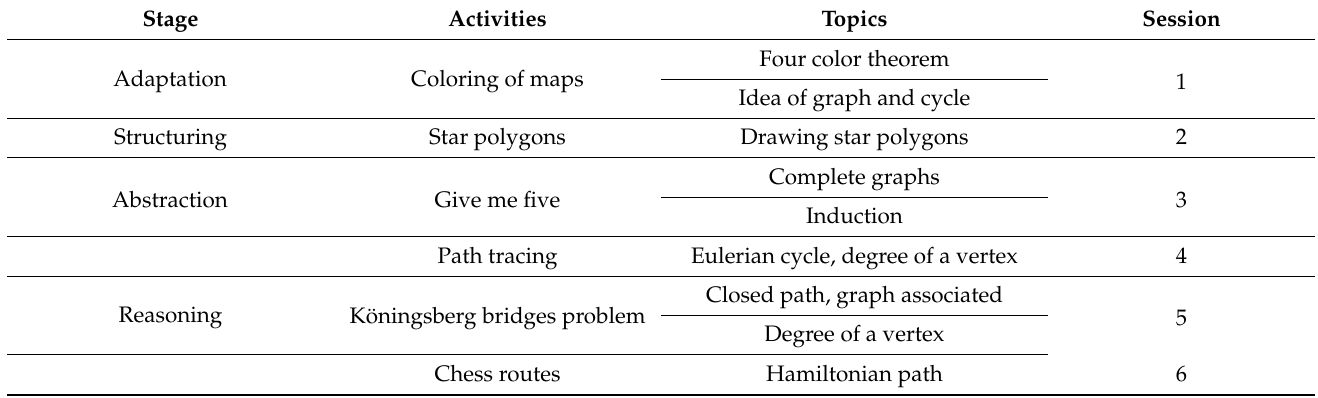
Table 2. Sessions, topics and activities.